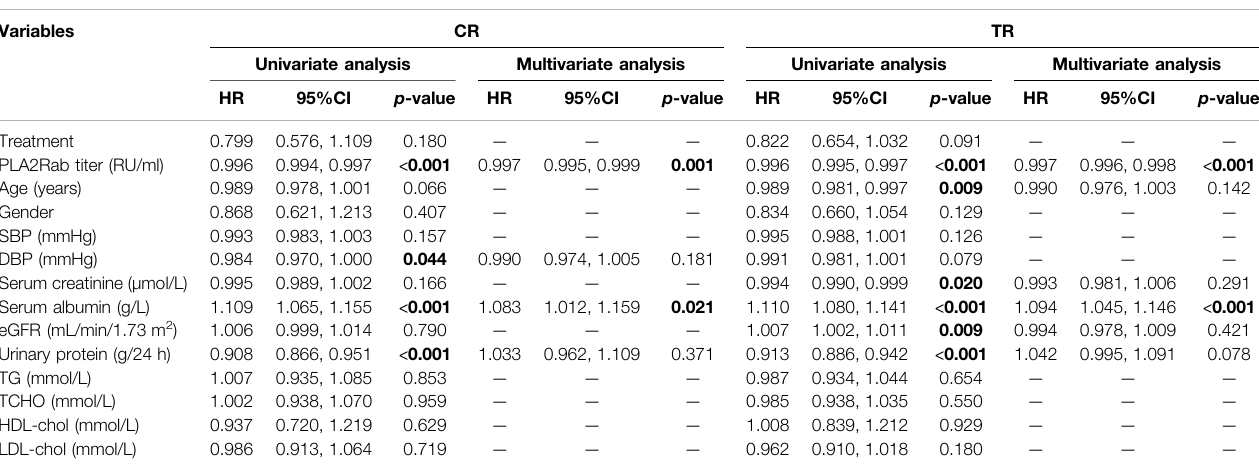
TABLE 3 | Factors predicting CR and TR for patients with seropositive PLA2R-associated MN.